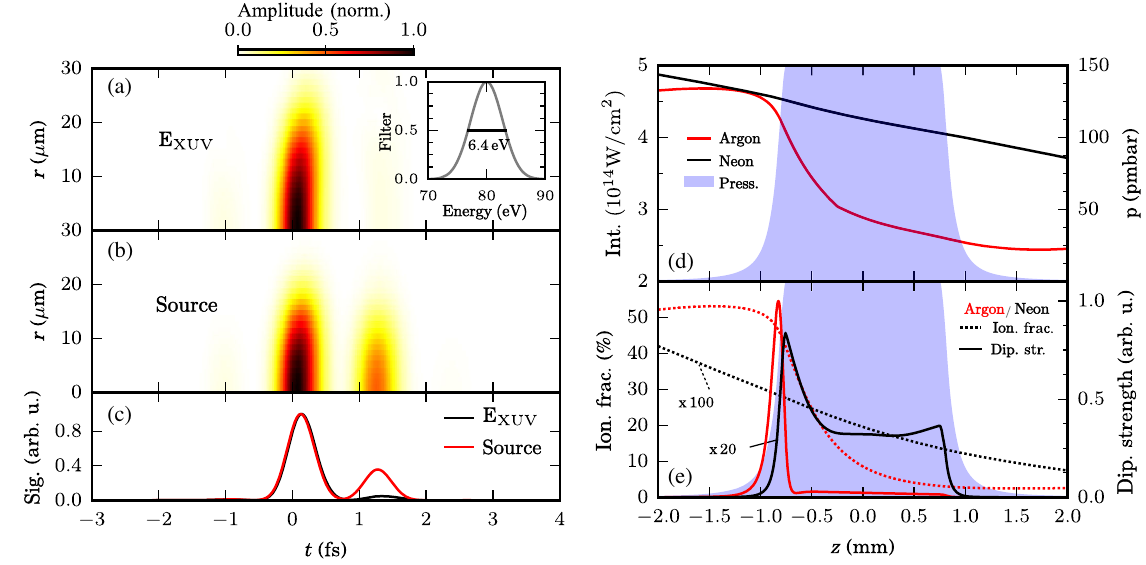
FIG. 2. Simulation of XUV generation in argon and evolution of the driving laser. (a) Spatiotemporal structure of XUV pulse at the end of the target calculated within the energy window illustrated by the inset, which shows an isolated attosecond pulse. (b) Spatiotemporal structure of the XUV source term within the above energy window integrated along the propagation axis assuming perfect phase-matching. (c) Comparison of the far-field XUV temporal profile at the position of the double mirror (solid black line) with the radially integrated source term from panel (b) (red). The absence of the satellite pulse at around 1.3 fs compared to the source term indicates that a transient phase-matching mechanism is present. (d) Evolution of the peak intensity of the driving laser pulse on the propagation axis within the gas target for neon (black line) and argon (red line). The blue shaded areas here and in panel (e) show the gas pressure distribution for both argon and neon. The propagation in argon is strongly influenced by the interaction with the gas. (e) XUV source term (solid line) within the energy region specified in the inset of panel (a) and the ionization fraction at the end of the pulse (dashed lines) for neon (black) and argon (red). The source term for argon is restricted to the entrance of the gas target. Note the different scaling for argon and